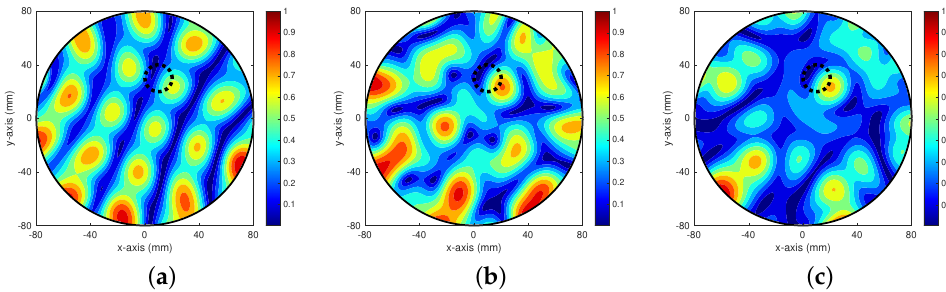
Figure 7. (Example 5) Maps of F BS ( r , n ) with datasets D s , s = 1,2,3. Black-colored dashed line describes the boundary of objective. ( a ) With dataset D 1 , ( b ) With dataset D 2 , ( c ) With dataset D 3 .